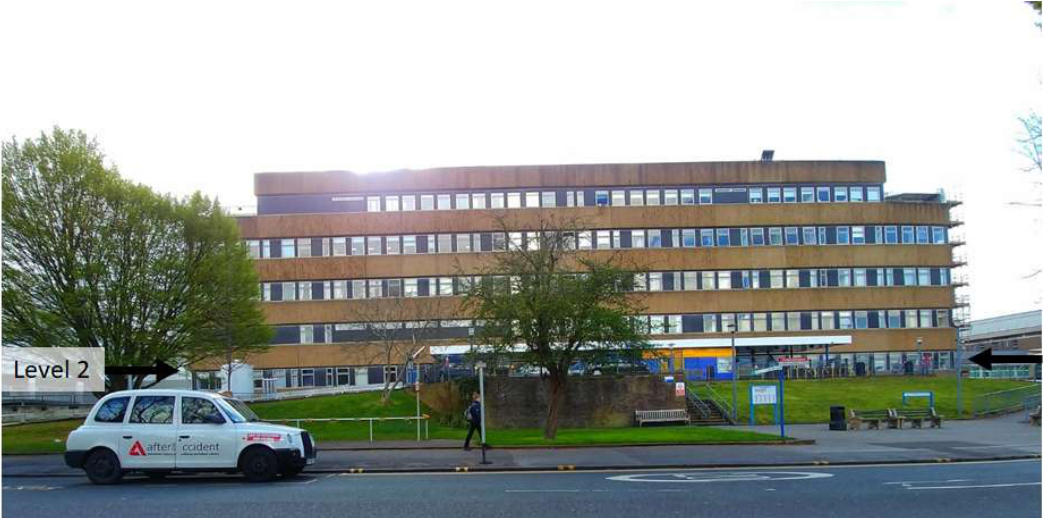
Figure 1. Photo of the Maternity and Gynaecology building taken from across the road. The black panels seen around the windows are asbestos. Level two is the ground floor of the building, highlighted by the black arrows, with the two entrances (Figure 2) located under the white awning.